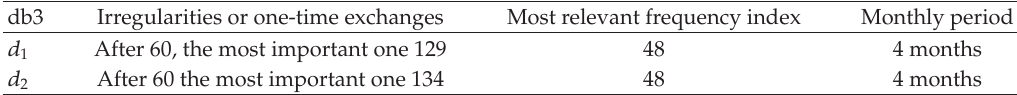
Figure 2: Daubechies continuous wavelet db3 filter of Spain INDEX. Table 1: Relevant frequency indices of Spain